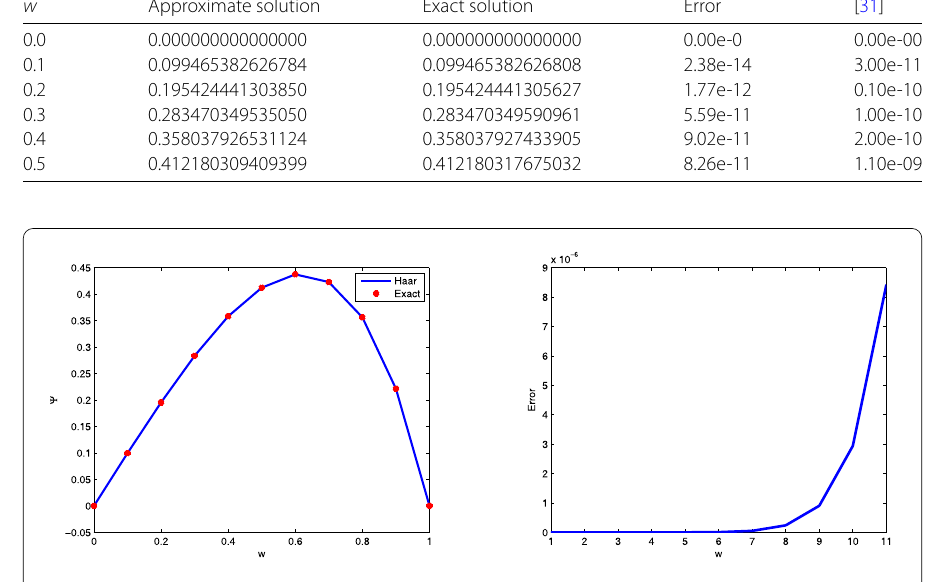
Figure 3 Solution profile of Example 5.3 for J =